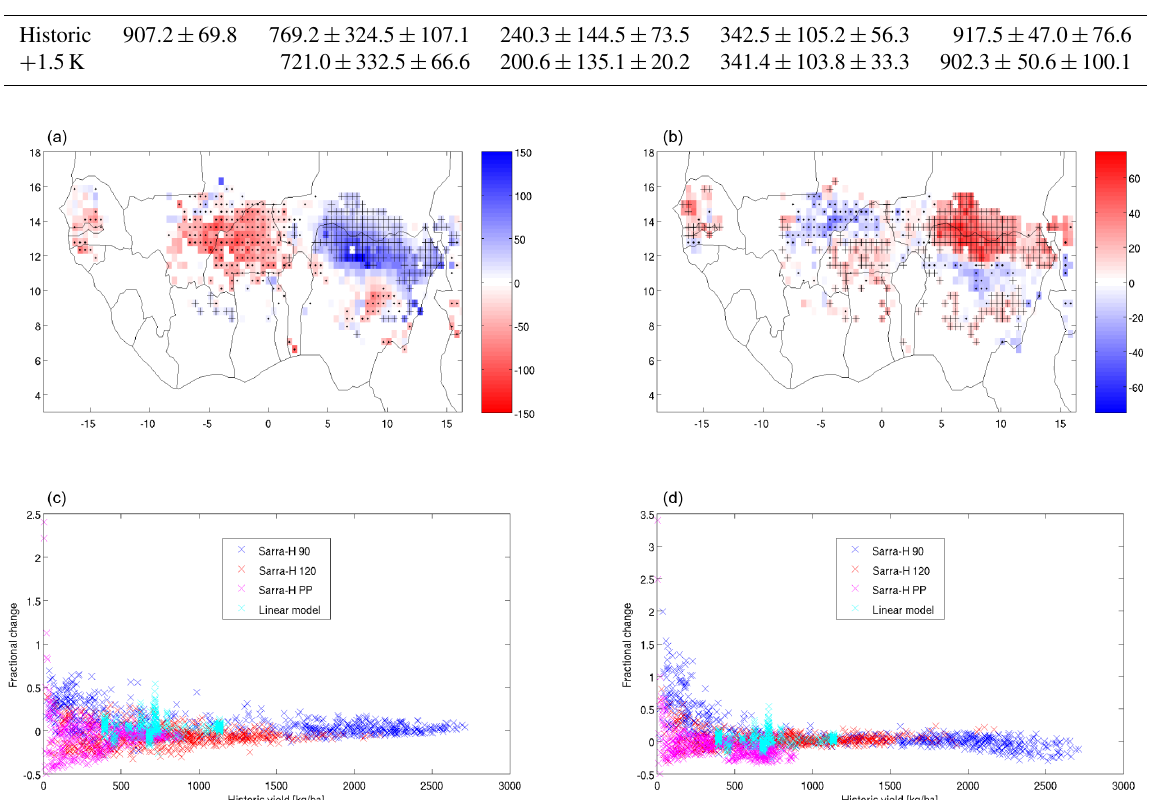
Figure 2. Change in millet yield and yield IAV between the historic and future climates. Panel (a) shows the change in yield where + indicates that in three crop models the change will be positive and · indicates that in three crop models the change will be negative. Panel (b) is the same as (a) except for IAV instead of yield. The units of the colour bar in the top plots is kilograms per hectare. Panel (c) shows the fractional change in yield against yield for all analysed grid cells. Panel (d) shows the fractional change in yield IAV against yield for all analysed grid